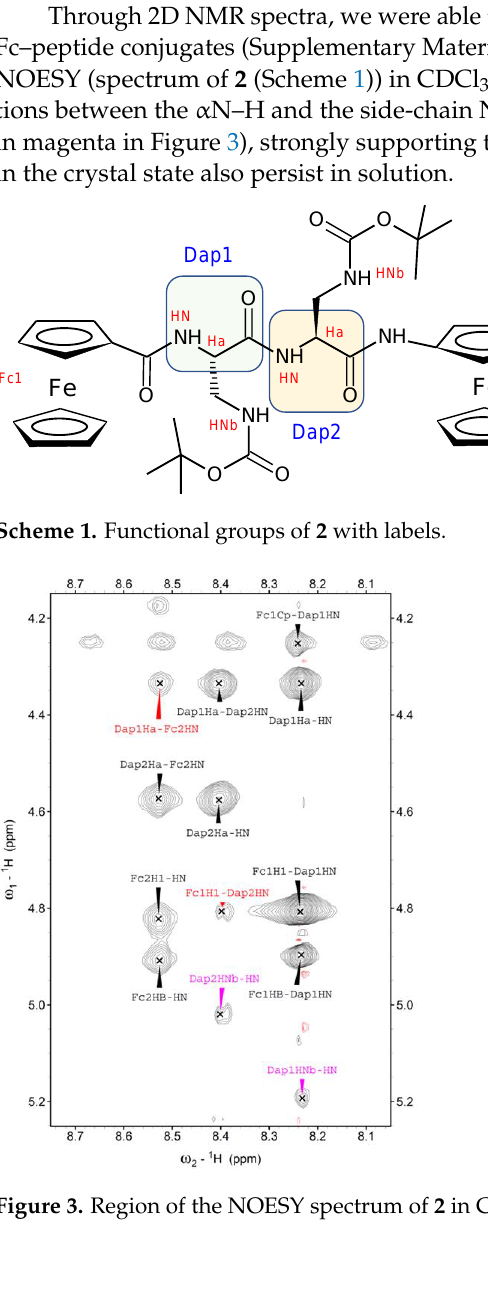
◦ 3 solution, T = 25